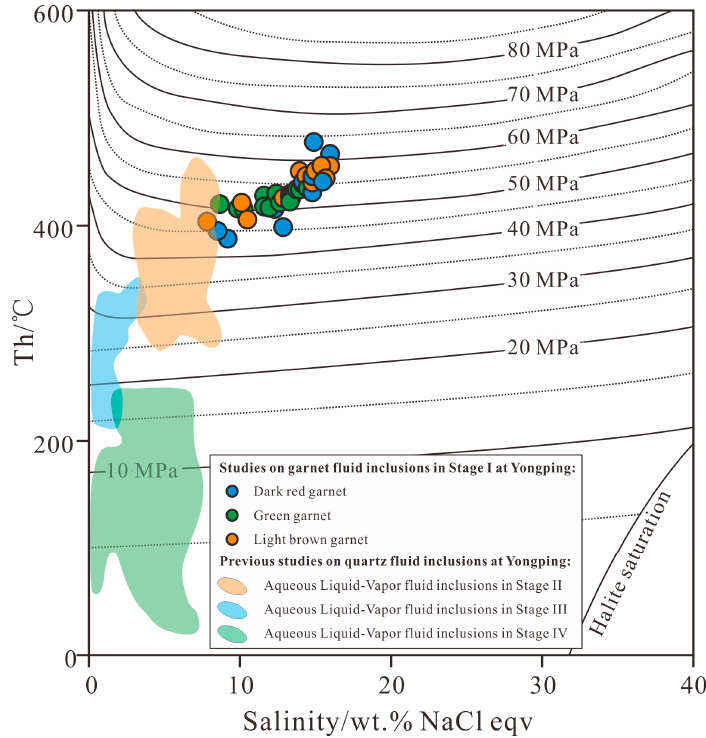
Figure 14. Homogenization temperature (Th, °C) versus salinity (wt % NaCl eqv) plots of boiling fluid inclusion assemblages from the Yongping garnets. Contours of trapping pressures (MPa) were calculated based on the correlations outlined by Driesner and Heinrich [82]. Aqueous Liquid-Vapor fluid inclusions fields were from [27]. Abbreviations: RGrt-s = zone with stronger color intensity under BSE of dark red garnet; RGrt-w = zone with weaker color intensity under BSE of dark red garnet; GGrt = green garnet; and BGrt = light brown garnet.